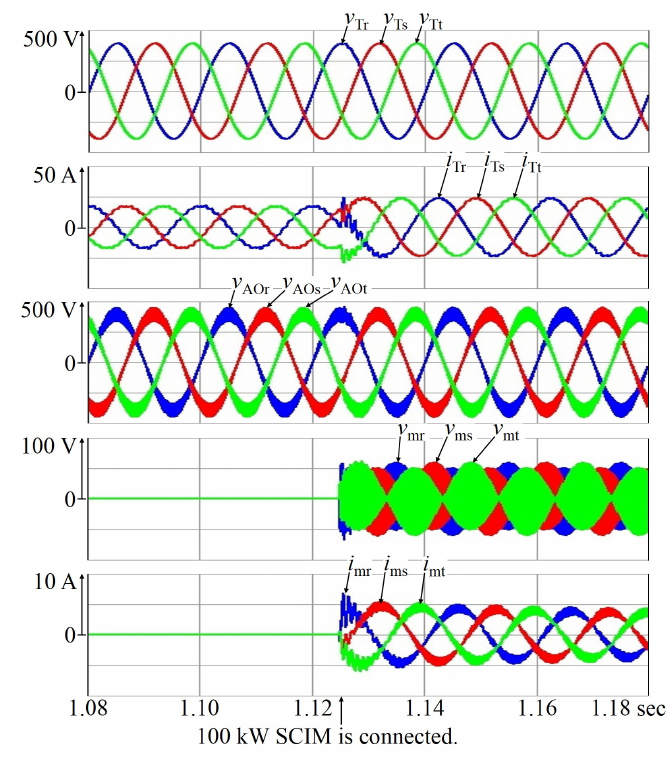
Figure 10. Simulation waveforms with the proposed inrush current suppressor for the 100-kW SCIM.